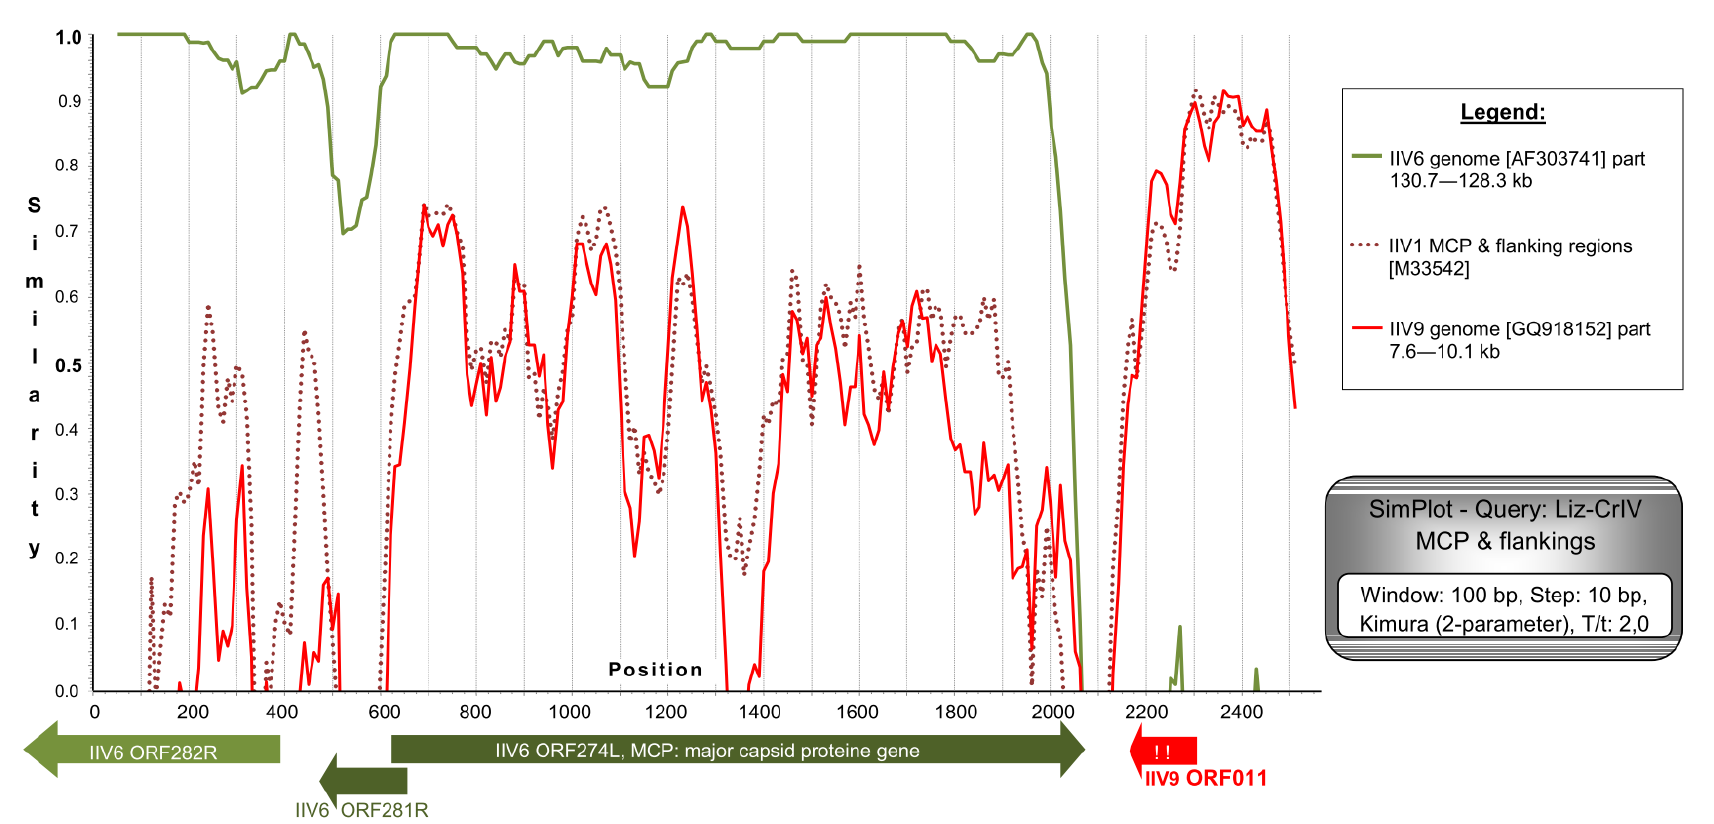
Figure 4. SimPlot analysis of the MCP gene with its flanking regions from our isolates. Three further members of the genus Iridovirus were available for the analysis in GenBank (IIV22 is highly similar to IIV1 and thus was omitted from the figure, for a better overview). Gene homologs with the highest BLAST values are drawn under the diagram. The region downstream of the MCP gene is a non-functional pseudogene homolog of IIV9 ORF011 . Exclamation marks indicate stop codons in this